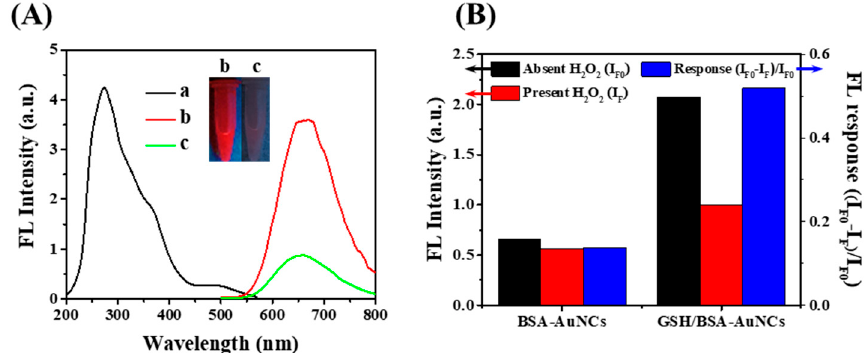
Figure 2. ( A ) The excitation ( λ em = 670 nm, spectra a) and emission ( λ ex = 320 nm, spectra b) in the presence of 1 mM H 2 O 2 (spectra c) fluorescence spectra of as-prepared GSH/BSA-AuNCs. The insert photograph displays the luminescence of the AuNCs in the absence and presence of H 2 O 2 under a 365 nm UV lamp. ( B ) Fluorescence ( λ ex = 320 nm; λ em = 670 nm) of 1 μ M BSA-AuNCs and GSH/BSA- AuNCs before (black) and after (red) addition of H 2 O 2 (200 μ M), and the corresponding response in fluorescence (blue).